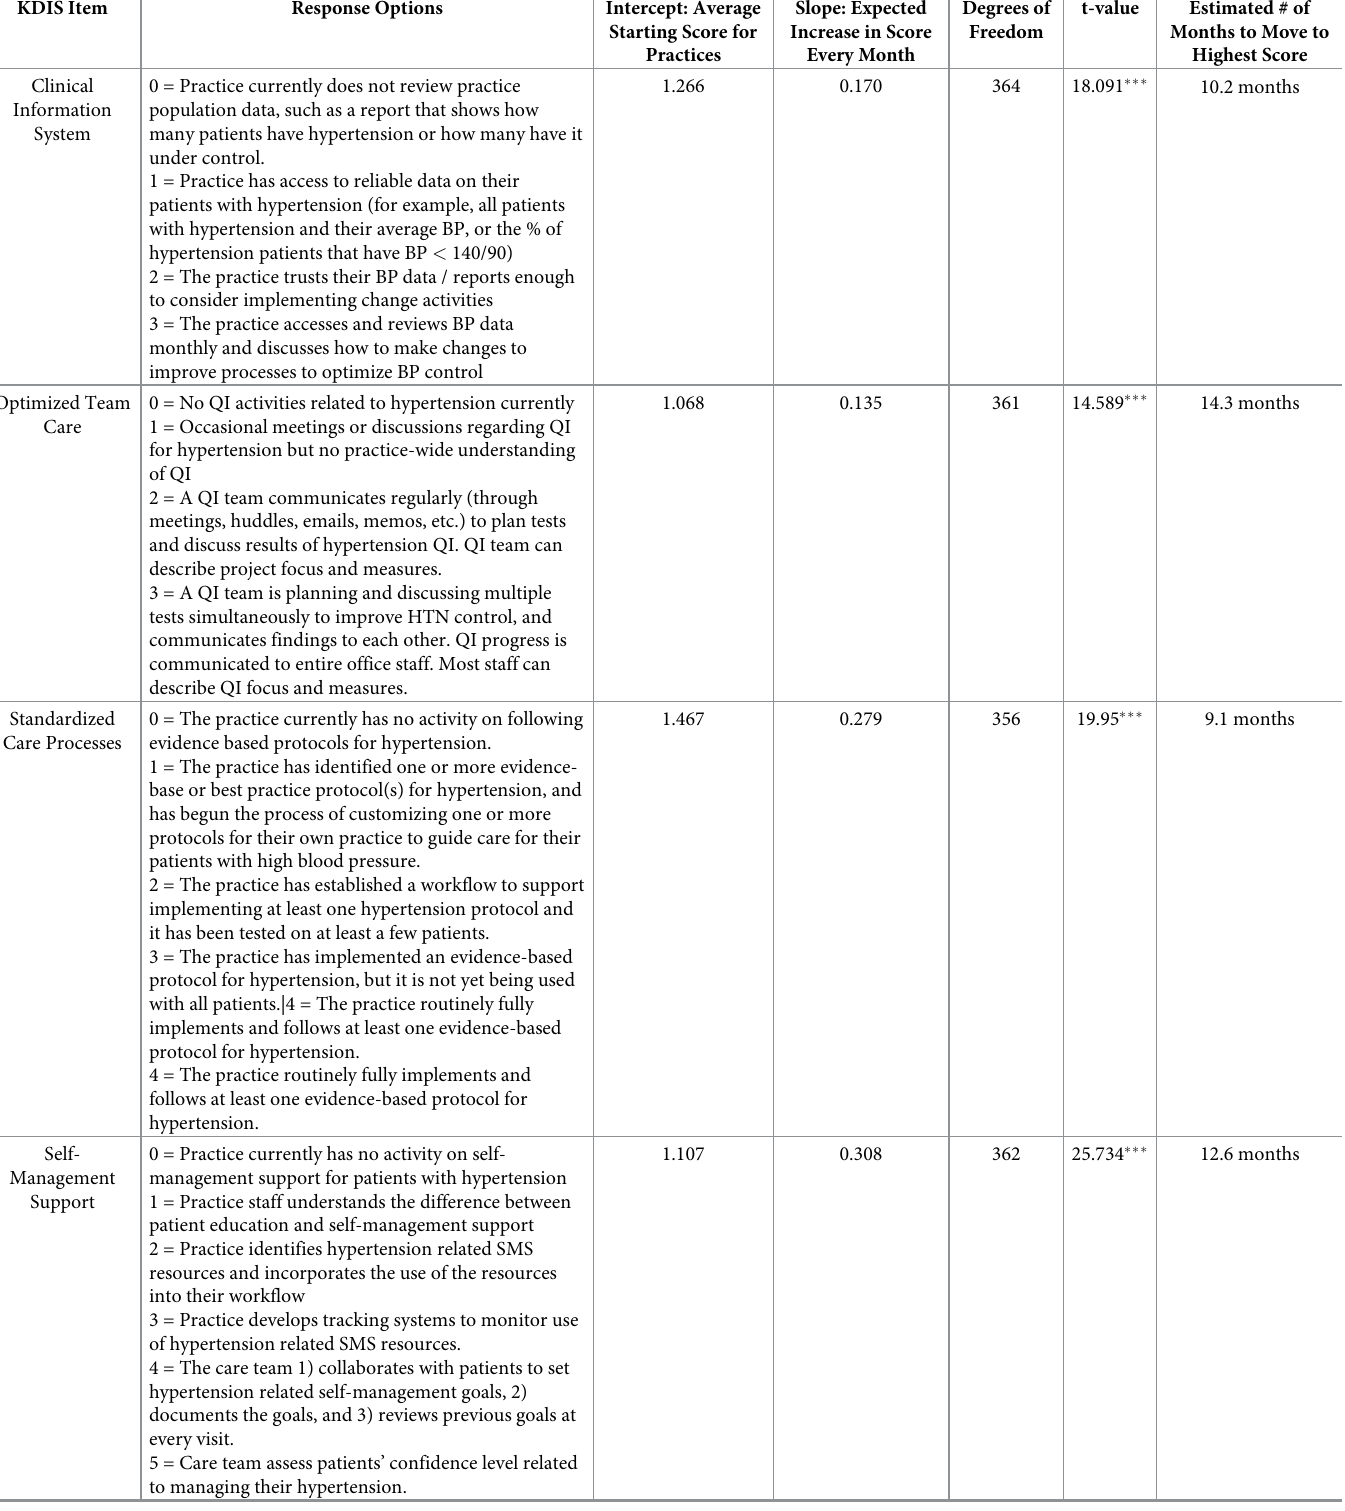
Table 4. Longitudinal trend test results for KDIS